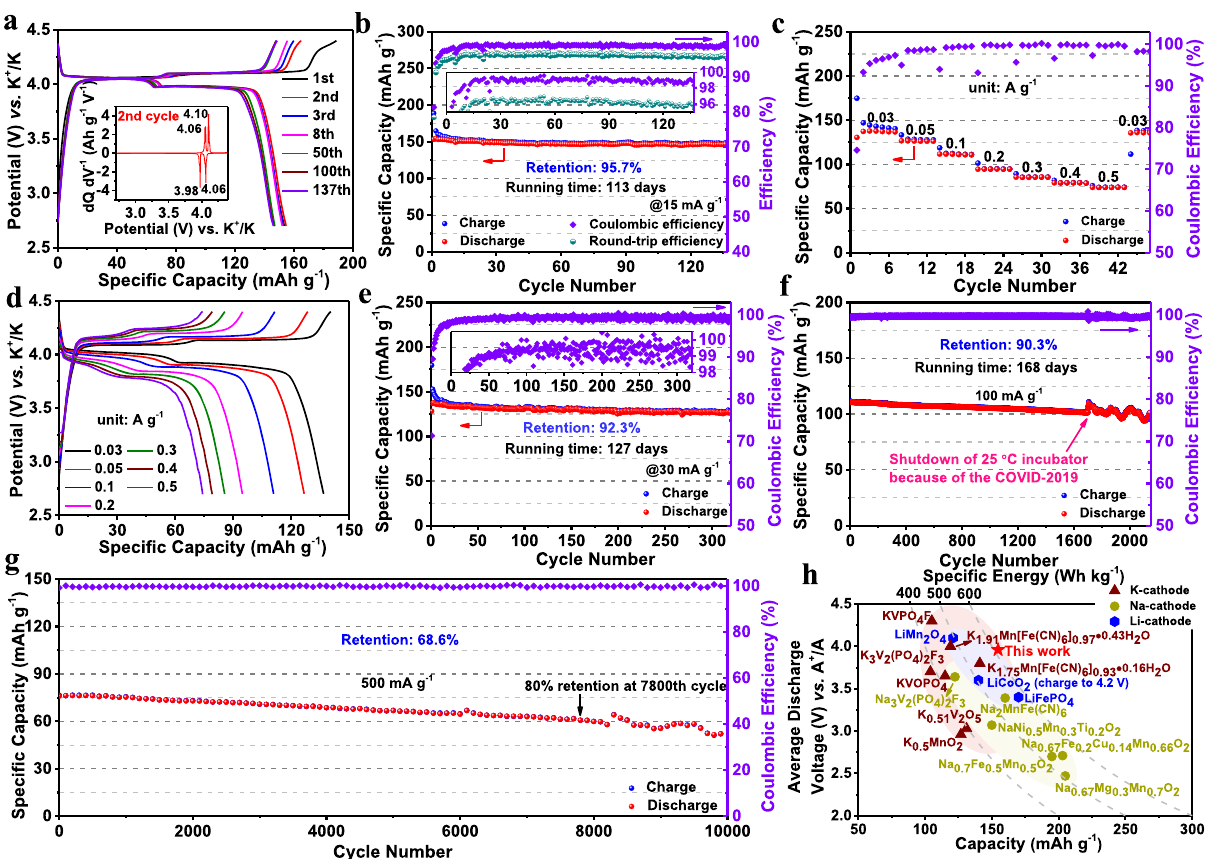
Fig. 3 Electrochemical performance of the KMF-EDTA | K metal cells within 2.7 – 4.4 V (vs. K + /K). a , b Galvanostatic charge – discharge voltage pro fi les ( a ) and cycling performance at 15 mA g − 1 (~0.1 C) ( b ). The inset in a shows the differential capacity (dQ dV − 1 ) curve of the 2 nd cycle. The inset in b